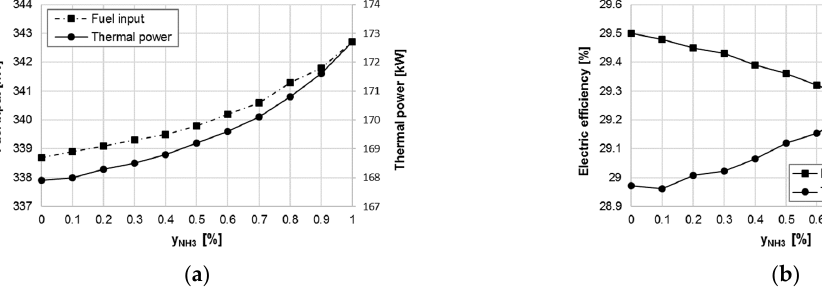
Figure 7. Effects of increasing ammonia blending ratio (y NH3 ) on: ( a ) fuel input and thermal power; ( b ) thermal end electric efficiency.